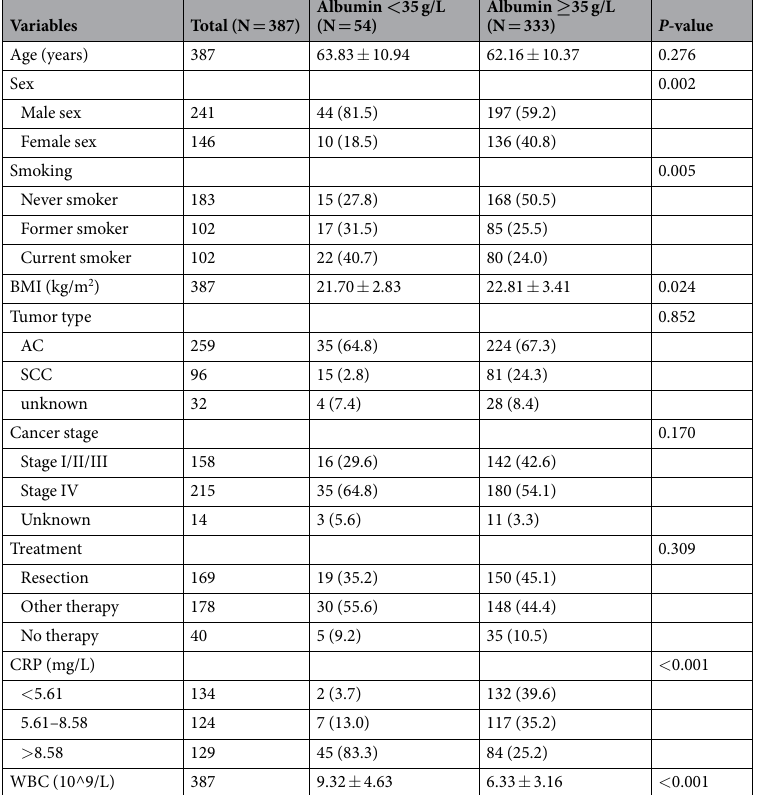
Table 2. The relationship between albumin and clinicopathological characteristics in NSCLC patients. BMI, body mass index; AC, adenocarcinoma; SCC, squamous cell carcinoma; CRP, C-reactive protein; WBC, white blood cell